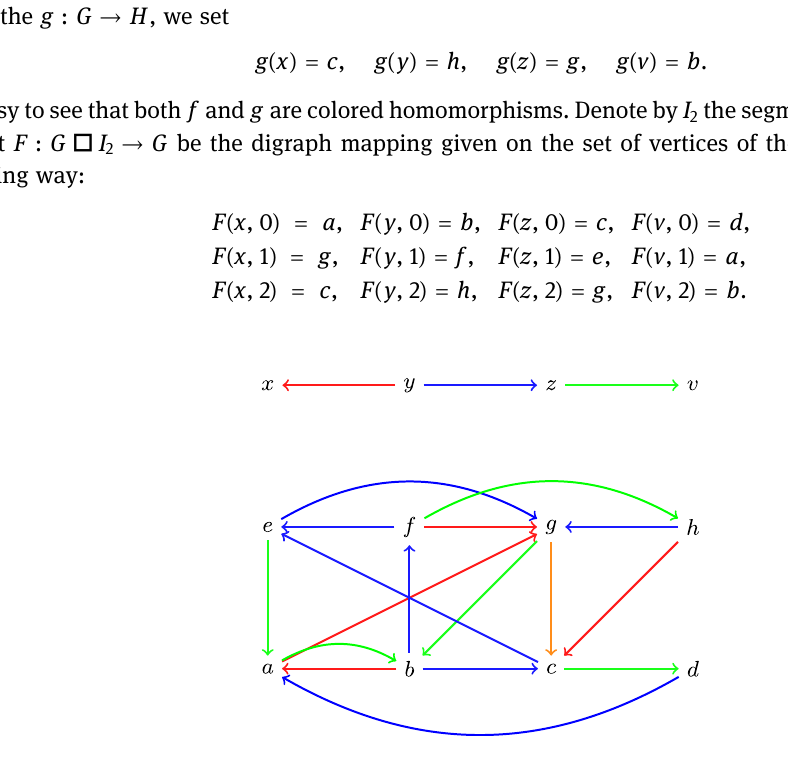
Figure 2: The edge - colored digraph G and H ,